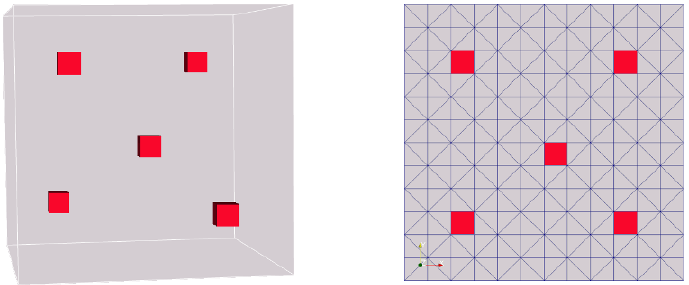
Figure 2. Medium 1: binary composite; matrix material (grey) and 1 × 1 × 1 inclusions (red); discretization in 12 × 12 × 12 voxels; each voxel is decomposed into 5 tetrahedrons; 3D view (left) and 2D projection with fine mesh, showing the position of the inclusions (right)